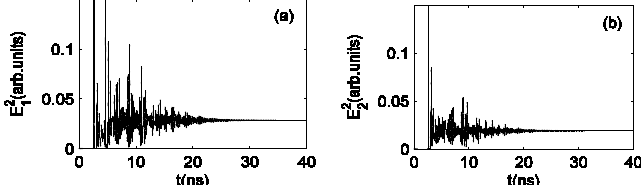
Fig. 5. Two lasers are becoming of two stable states. (a) laser 1 is controlled to a stable state. (b) laser 2 is controlled into another stable state.